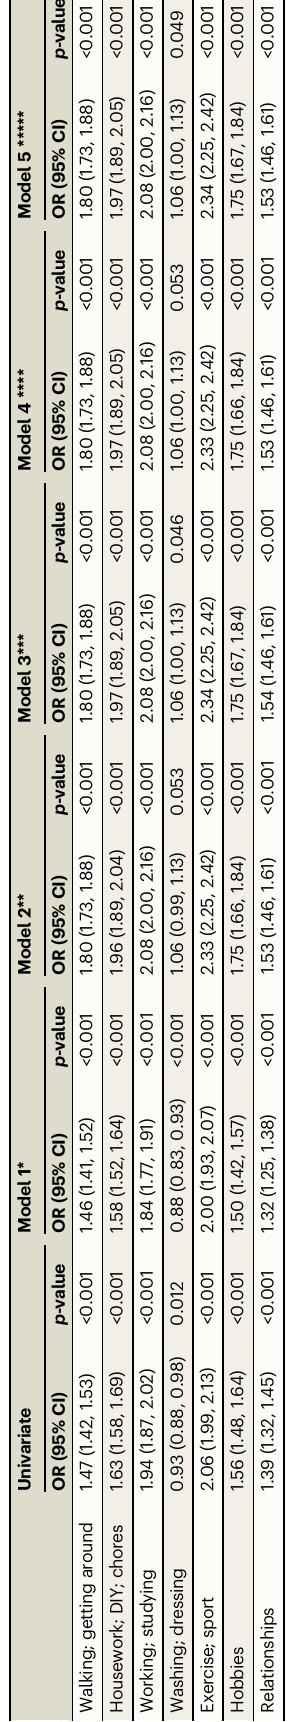
Table 5 | Multivariate logistic regression analysis of the fac- tors associated with no or partial recovery, referent to full recovery, among people with previous symptomatic SARS- CoV-2 infection